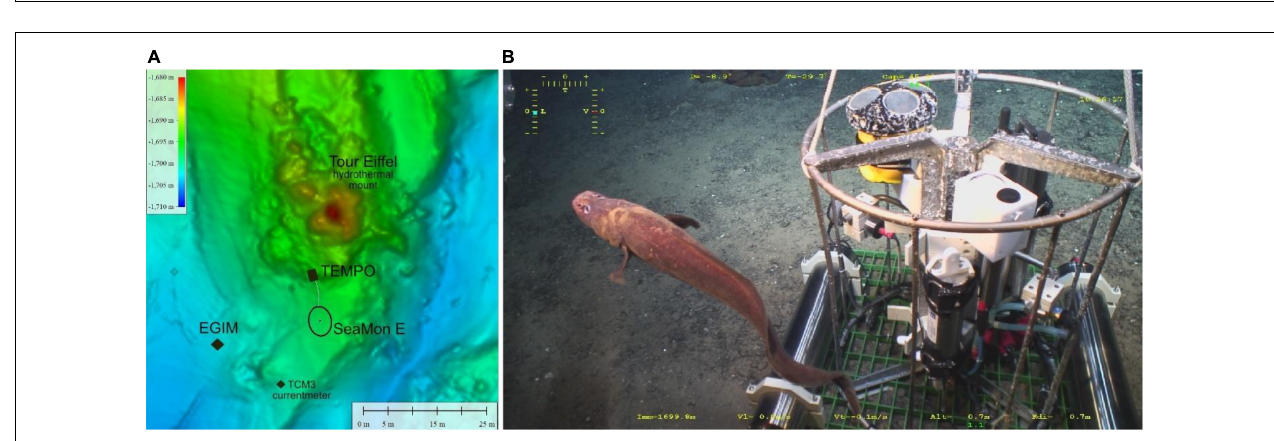
FIGURE 6 | Integrated chart of significant daily increases (mean values above the MESOR in each waveform plot) for the 5 biologically relevant oceanographic variables and visual counts of the 19 taxa , unclassified and total fish. Dark gray horizontal bars report values above the MESORs for the oceanographic variables, black horizontal are used for visual counts and light gray boxes show the duration of night hours.